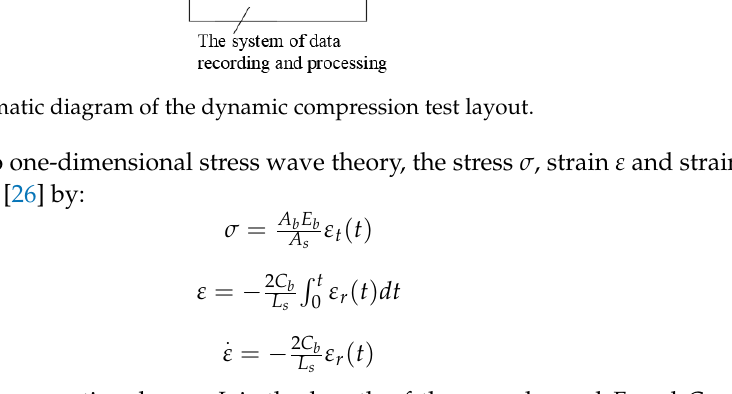
Figure 4. Assembly drawing of the long rod projectiles (LRPs) and sabot (Unit: mm). The experimental layout is shown in Figure 5. Annealed FeNiCoCr HEAs LRPs were launched by a 14.5 mm ballistic gun under different velocities ranging from 650 m/s to 1500 m/s. The trajectory of the projectile and penetration process was recorded by a high- speed camera. The impact velocities of the LRPs were calculated by analyzing the relative position recorded in the background screen. The muzzle was 1.2 m away from the semi- infinite steel target with a diameter of 120 mm and a length of 100 mm, while the trajectory line was perpendicular to the target surface. The projectile velocity was controlled by ad- justing the mass of the propellant.